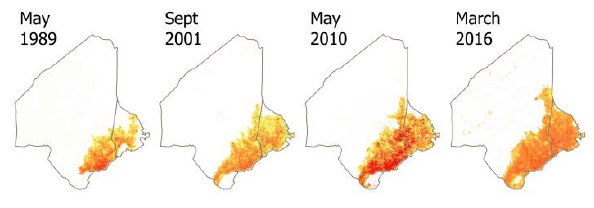
Figure 4. The extent of the Cebu City - Mandaue City urban heat island for select dates.